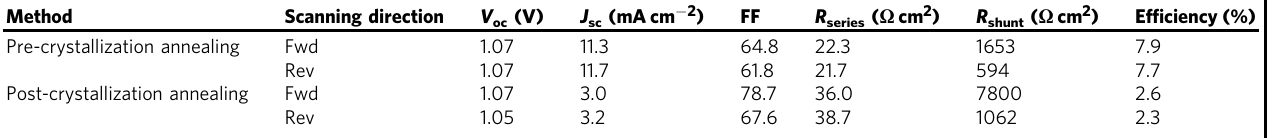
Table 1 Solar cell parameters of the pre- and post-crystallization annealed devices Method Scanning